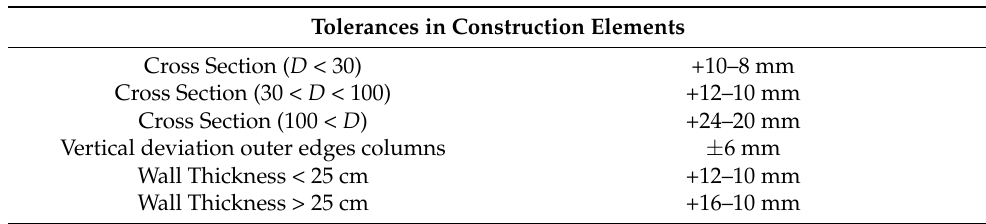
Table 4. Tolerances in the different structural elements according to [26]. “ D ” represents the transver- sal dimension of the